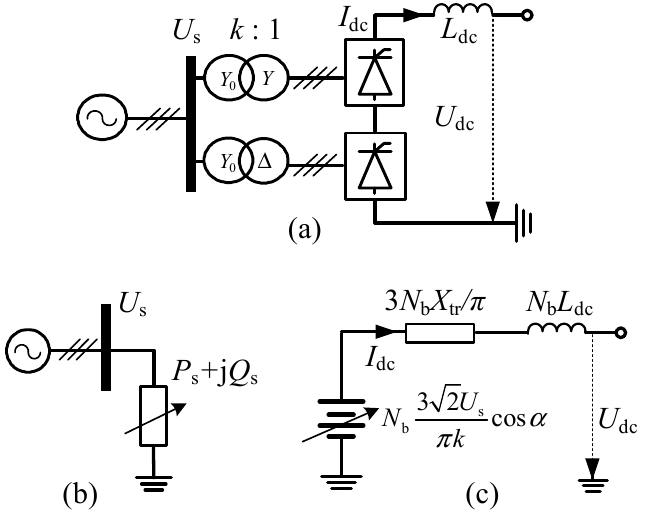
Figure 3. Schematic circuit of the LCC station. ( a ) 12-pulse bridge converter; ( b ) AC-side model of the LCC; ( c ) DC-side model of the LCC.